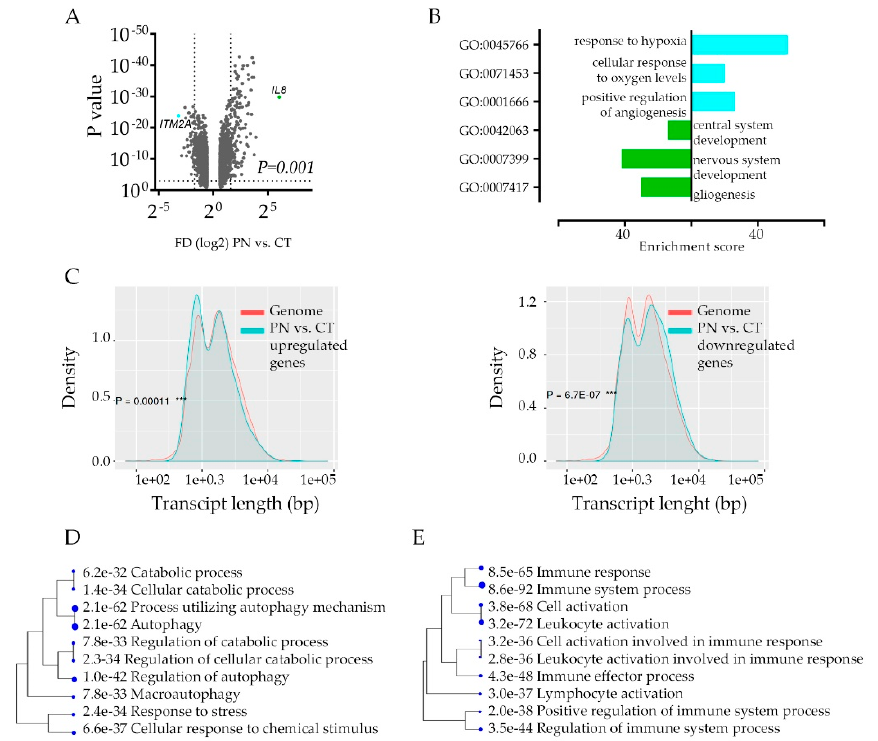
Figure 2. Gene Ontology enrichment analysis in hypoxic feature using Ivy GAP database: ( A ) CT vs. PN differential gene expression analysis ( n = 2707) by volcano plot shows the most ( p -value < 0.01. FD2, denoted by dashed lines) up- and down-regulated genes in the PN feature of glioblastoma tumor ( n = 366, and 556, respectively). ( B ) Gene ontology analysis showing top three most enriched biologic functional categories of genes up- (blue) and down-regulated (green) in PN vs. CT glioblastoma anatomic feature. ( C ) The characteristics of genes down- ( n = 366, left) and upregulated ( n = 556, right) in PN in comparison with the rest of the transcripts in the human genome based on the transcript length. ( D , E ) A hierarchical clustering tree summarizing the correlation among significant: unique autophagy pathways genes ( D , gene n = 64) and immune system pathway genes ( E , n = 451) in PN in comparison to CT feature. Pathways with shared genes are clustered together. Bigger dots indicate more significant p -values.